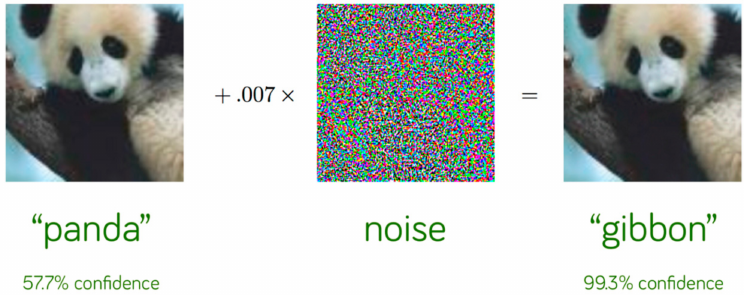
Figure 1. Prediction before and after attack [9].